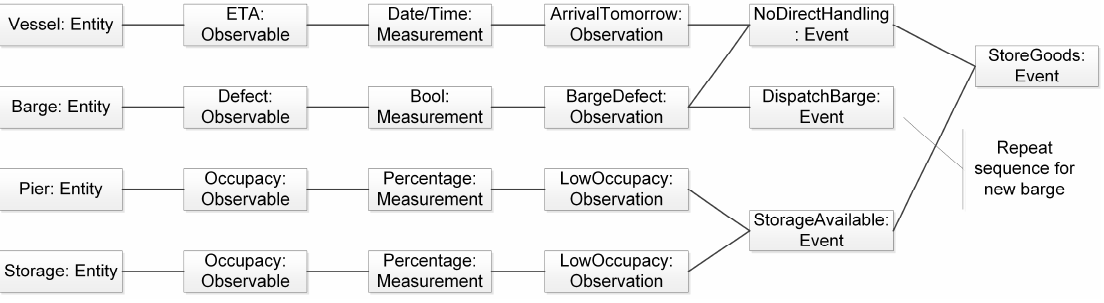
Figure 10. Exception “StoreGoods”.